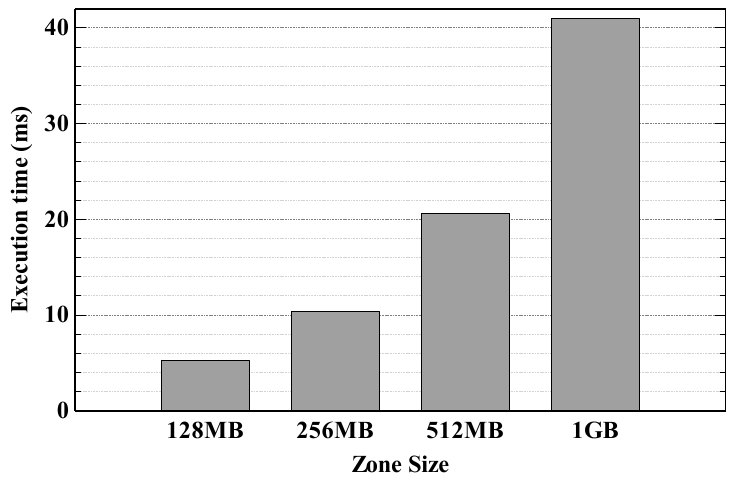
Figure 2. Average block erase execution time by zone